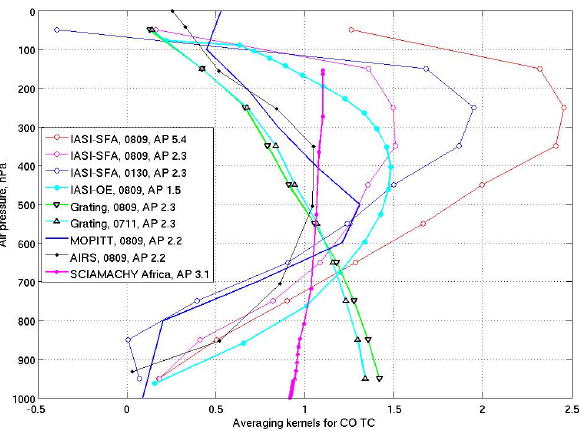
Fig. 3. Daily mean CO TC retrieved from spectra recorded by 3 sounders over grid cell centered at 55.5 ◦ N and 36.5 ◦ E. Data of Zvenigorod spectrometer play a role of ground truth. Vertical bars are standard deviations of individual